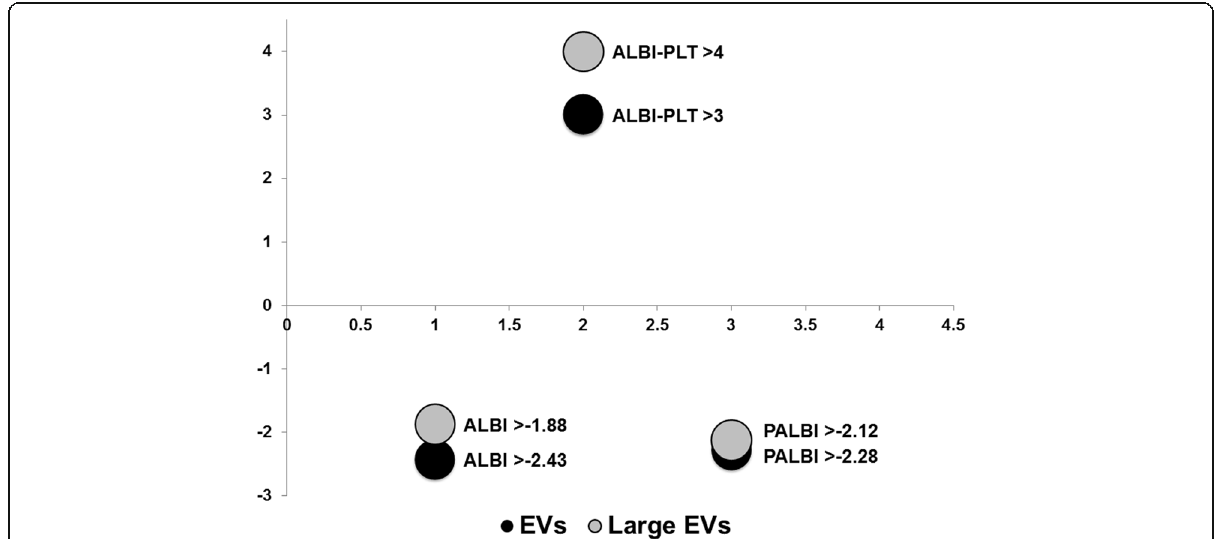
Fig. 4 the cutoffs pf ALBI, ALBI-PLT and PALBI for esophageal varices and large varices discrimination